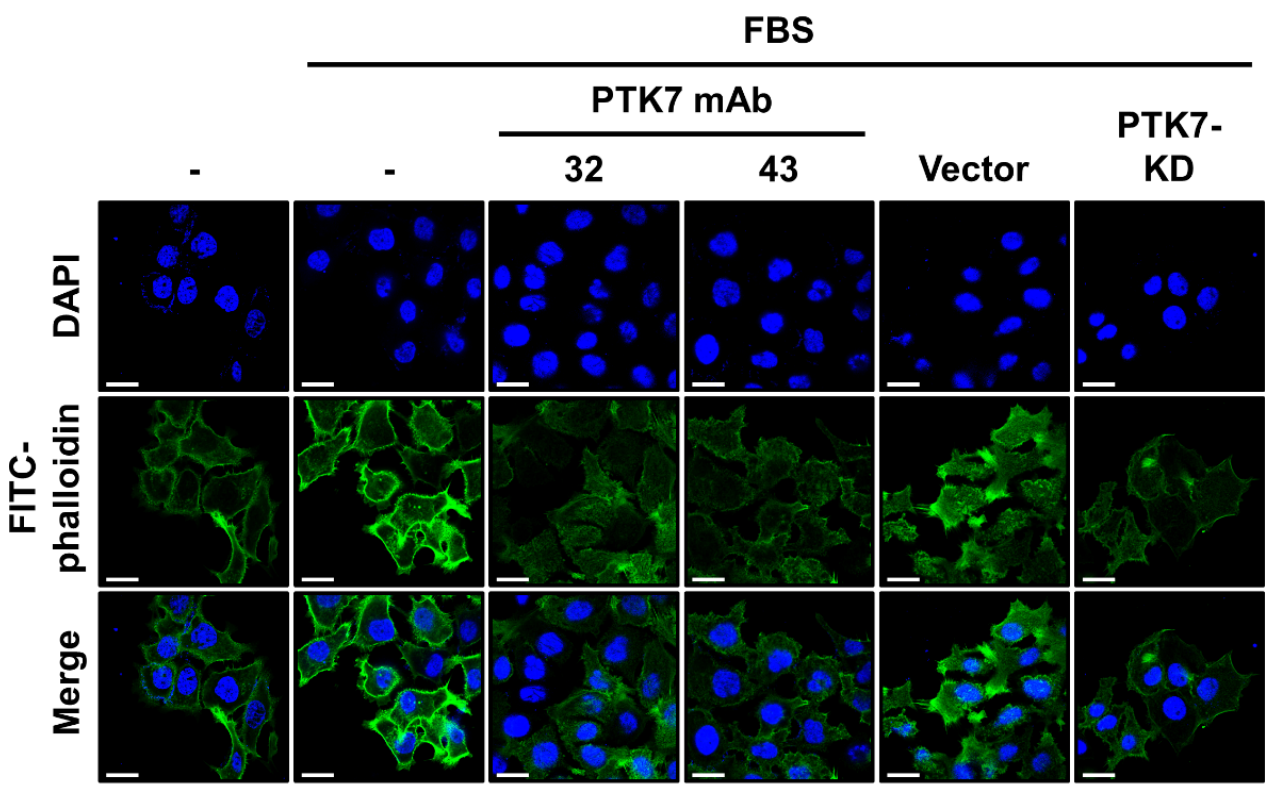
Figure 4. PTK7 mAbs inhibit actin polymerization in KYSE-30 cells. KYSE-30 cells were incubated in DMEM/F12 medium with or without 2% FBS in the presence of PTK7 mAb (10 μg/mL) for 24 h. KYSE-30 cells infected with the vector or PTK7 knockdown viruses were used as controls. The cells were fixed with 3.7% paraformaldehyde (PFA), and the actin filaments (green) and nuclei (blue) were stained with FITC-conjugated phalloidin and 4 ′ ,6-diamidino-2-phenylindole (DAPI), respectively. The scale bar represents 20 μm.